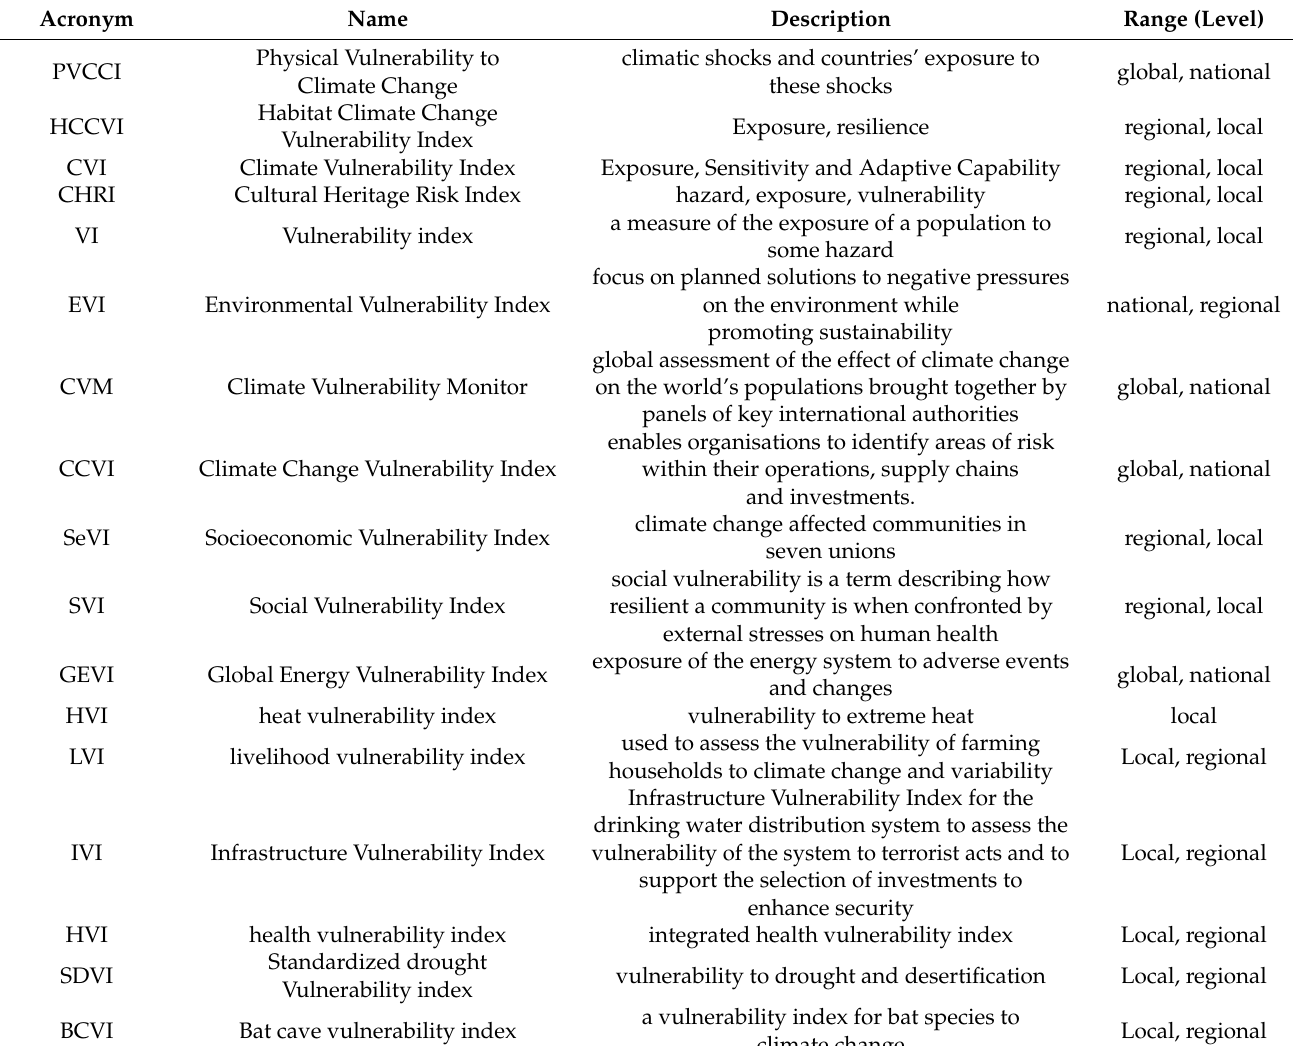
Table 1. A list of indices describing vulnerability with their spatial